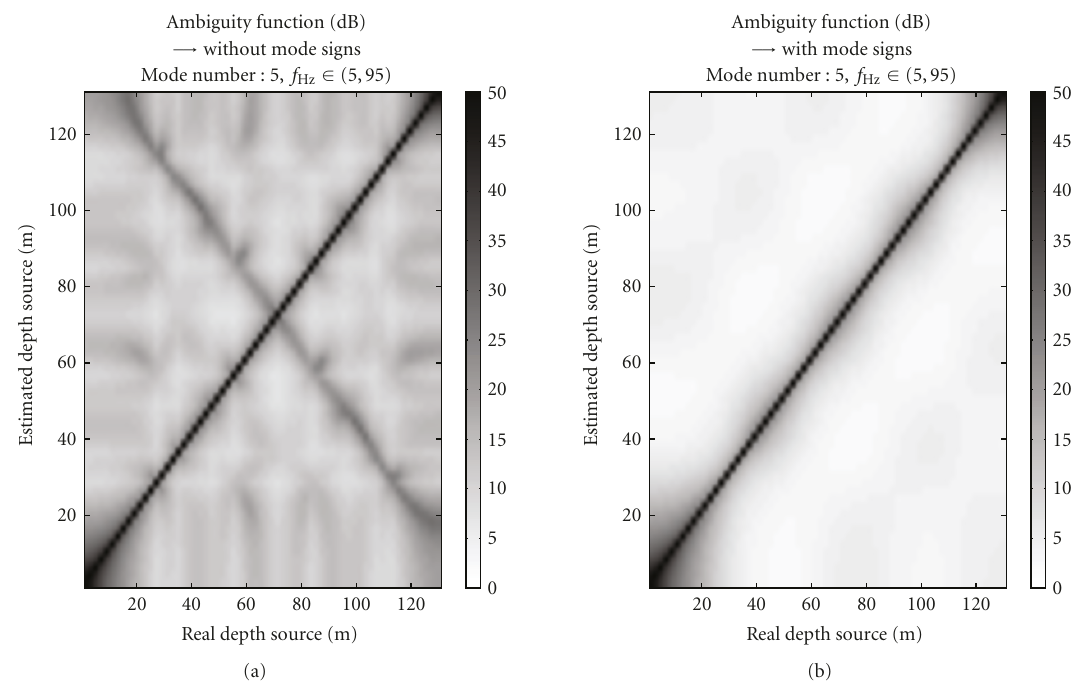
Figure 14: Theoretical ambiguity functions for matched-mode localization. Results obtained for the set of modes 1 to 5 and frequency band (5,95)Hz. In (a) the contrast function G is calculated at the basis of mode excitation factor modulus, and in (b) the mode sign information is